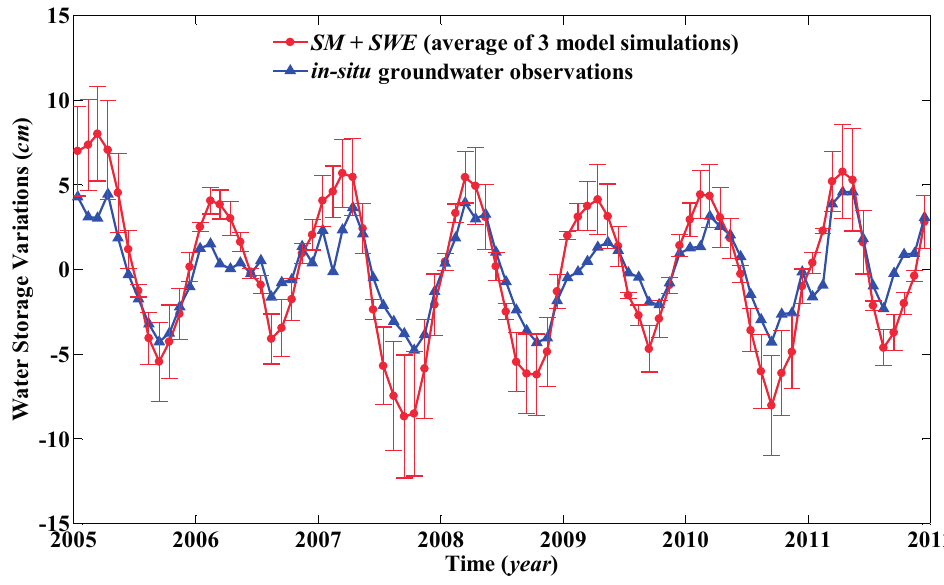
Figure 2. Monthly soil moisture (SM) and snow water equivalent (SWE) from Global Land Data Assimilation System (GLDAS) models and groundwater storage from monitoring wells. The error bars represent the standard deviations for the GLDAS model simulations. The soil moisture and accumulated snow variation is featured by a prominent seasonal character, with the annual amplitude of around 5.39 ± 0.28 cm. Groundwater is also characterized by evident seasonal variations, with its annual amplitude as 2.62 ± 0.23 cm, smaller than that of soil moisture and accumulated snow. The phase difference between the two series is approximately 11 days, and generally in-situ observations lag the simulated SM and SWE. The simulated soil moisture and accumulated snow variations exhibit stronger magnitude than the monitoring well groundwater records. The changes of soil moisture and accumulated snow may take the largest part of TWS variations. This implies these two components ( i.e. , SM and SWE) are the dominant contributors to TWS changes in this